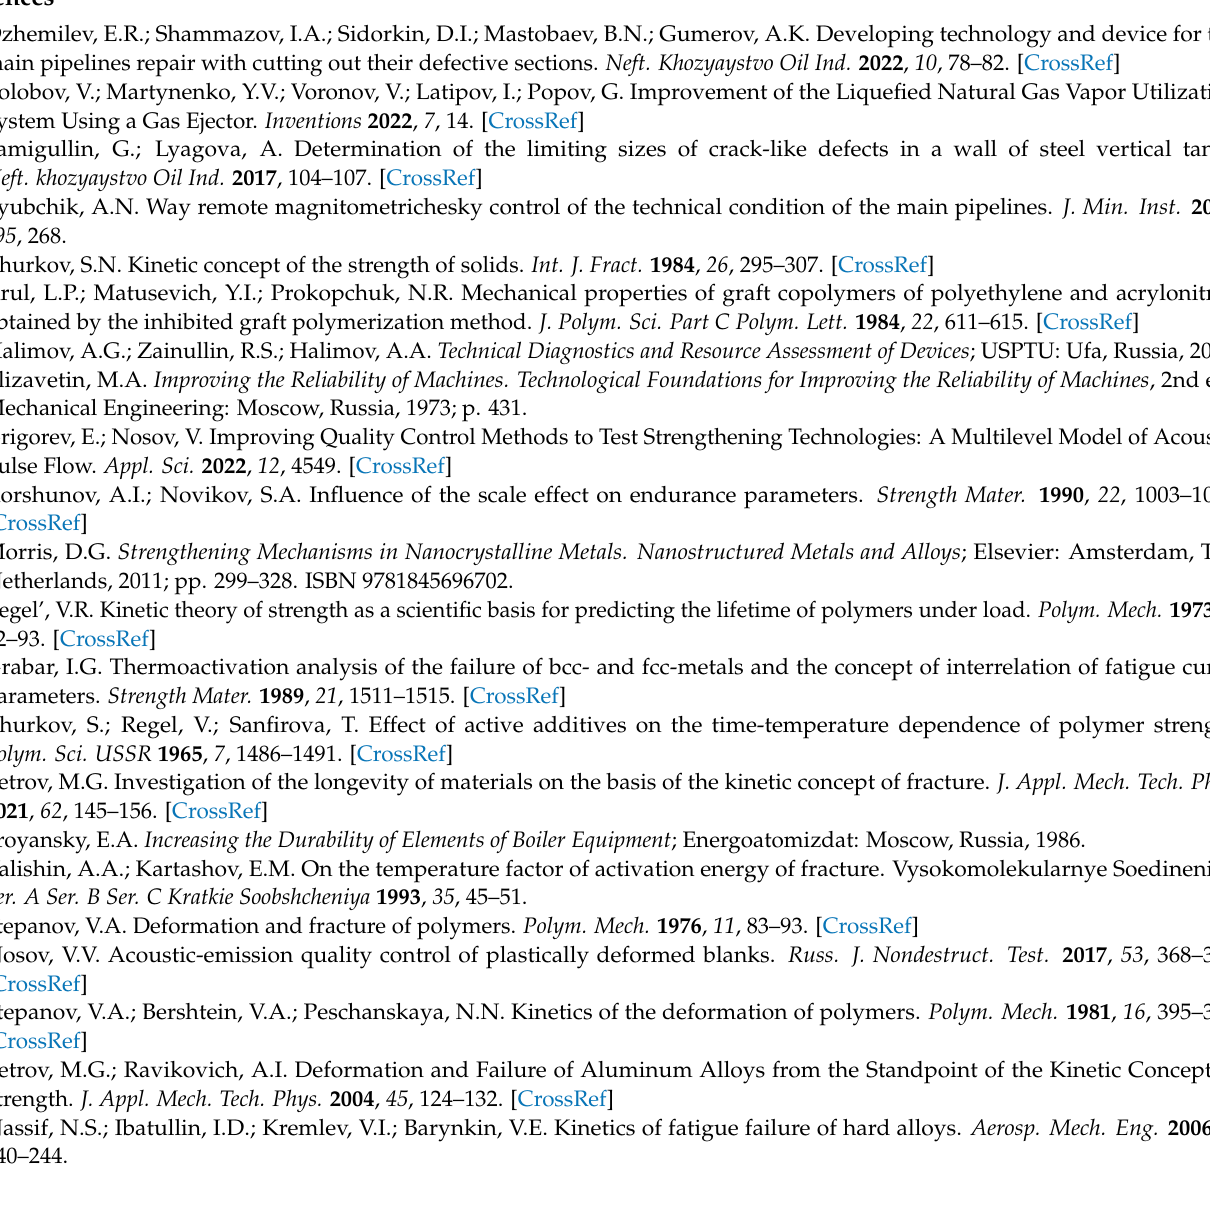
Figure A19. S–N Curve—Al 5052 alloy (Temperature—293 K; frequency—4 Hz). Source—Base Total Material.